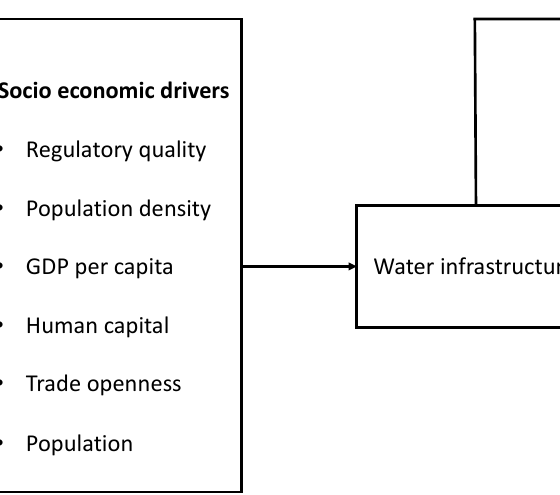
Figure 1. Research conceptual model.